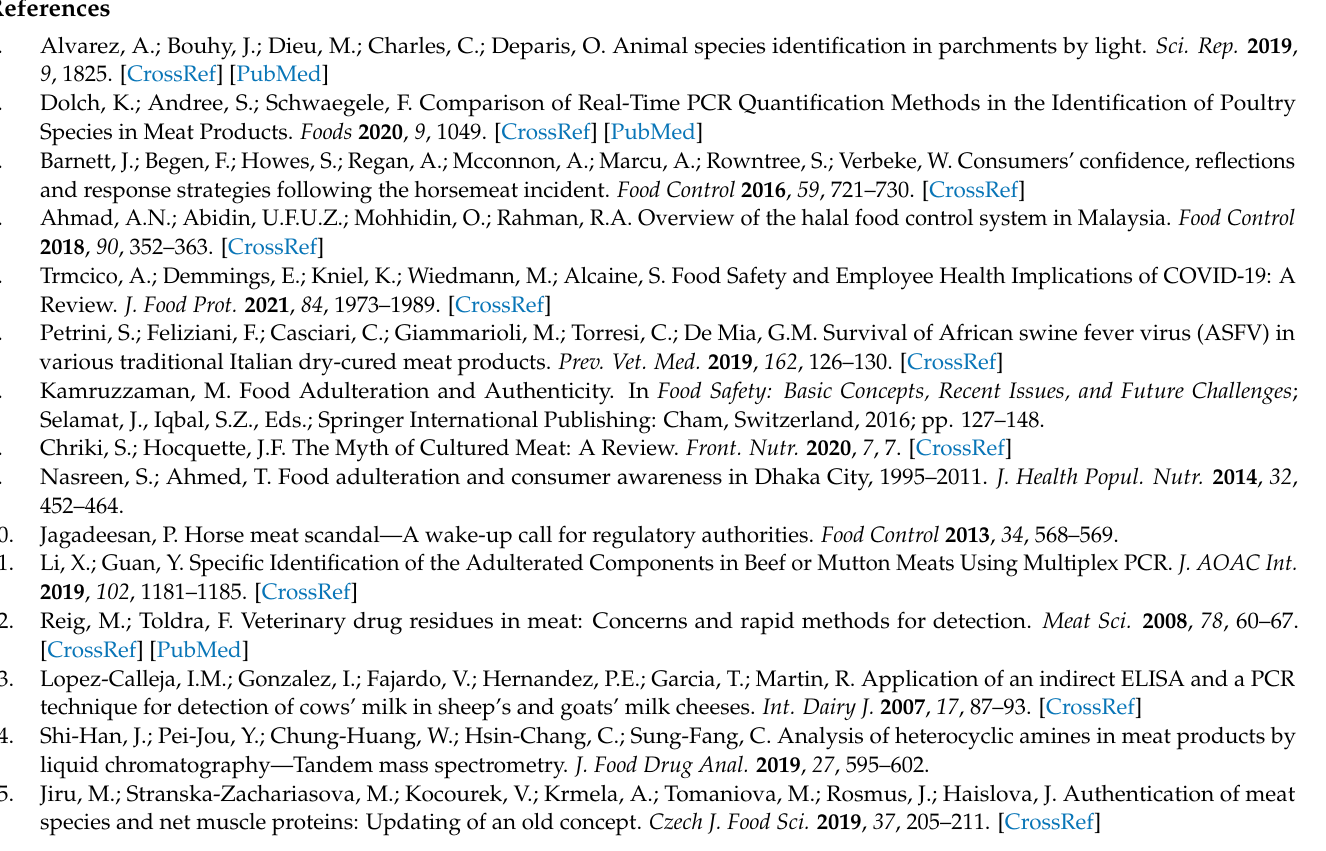
spectively; Figure S2: Screening of LAMP primers targeting porcine, chicken and duck mito- chondrial genes; Figure S3: Agarose gel electrophoresis determination of the limit of detection for LAMP amplification; Figure S4: Agarose gel electrophoresis of species-specific PCR. Table S1: PCR study; Table S3: ssDNA-reporters and crRNAs used in this study; Table S4: Species Information; Table S5: Simulate mixed meat products